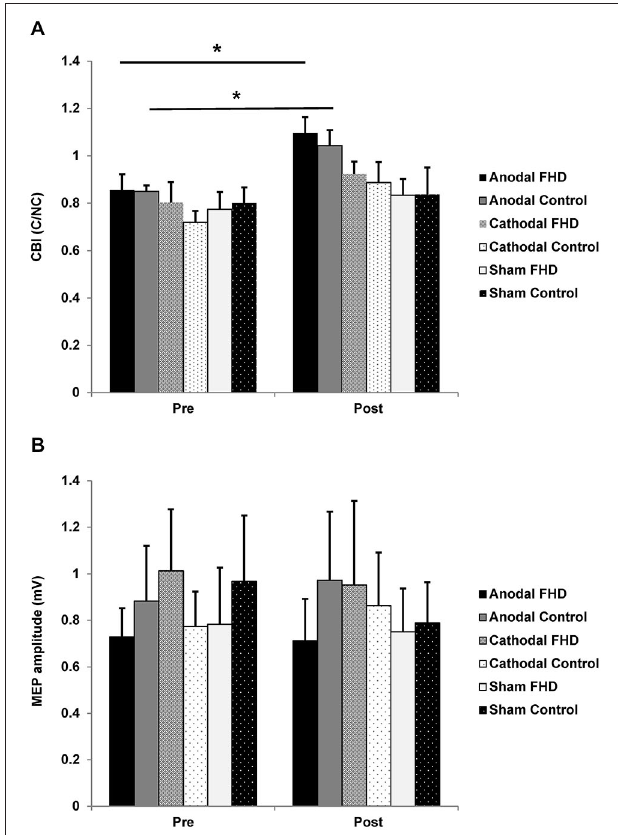
FIGURE 2 | Effect of transcranial direct current stimulation (tDCS) on cortical neurophysiology . (A) CBI. There was an increase in CBI in both groups following anodal tDCS. (B) There was no change in MEP amplitude in either group. Significance at P < 0.05 is signified by *.